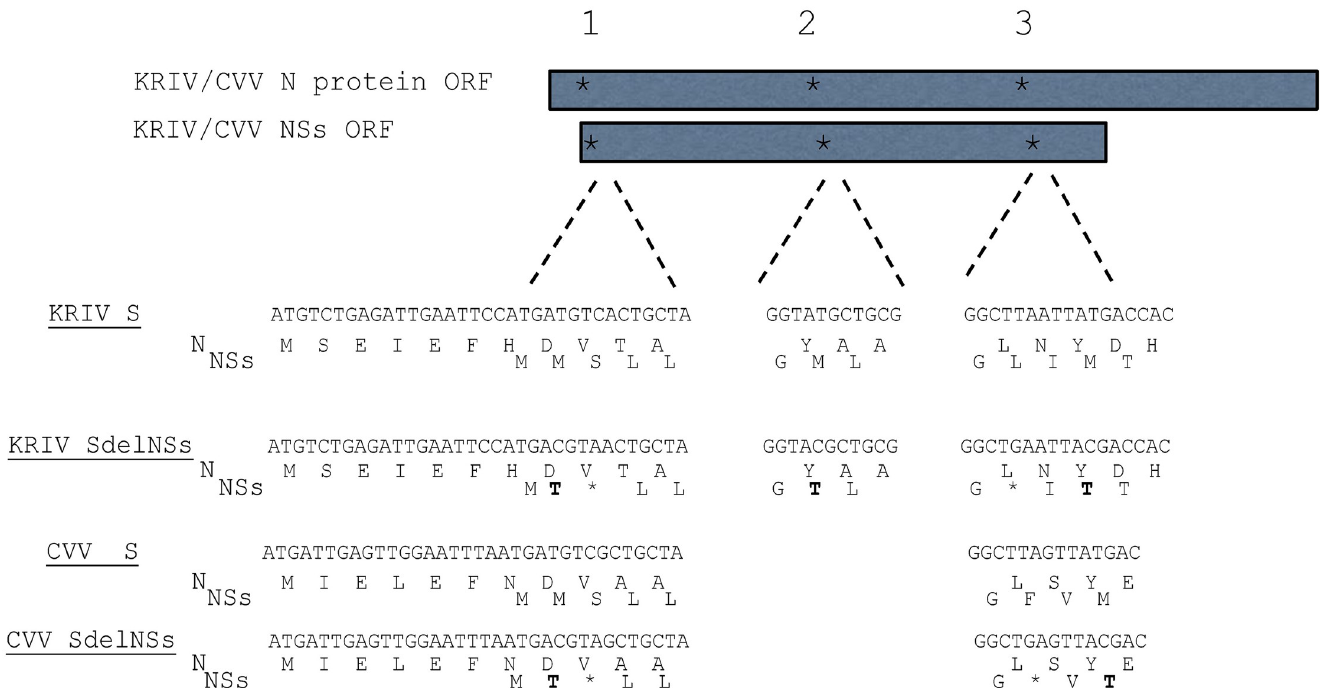
Fig 2. Design of CVV and KRIV that do not express NSs. Shown are sections of S segment for the N-termini of the N and overlapping NSs proteins. Mutations were added to disrupt the reading frames of the NSs proteins for both viruses, without changing the amino acid sequence of the overlapping N protein. For CVV, two methionines were changed to threonine (denoted in bold) and two stop codons introduced (denoted with an asterisk). For KRIV, mutational sites were used where three methionines were changed to threonines and two stop codons introduced. Protein representation is not to scale.